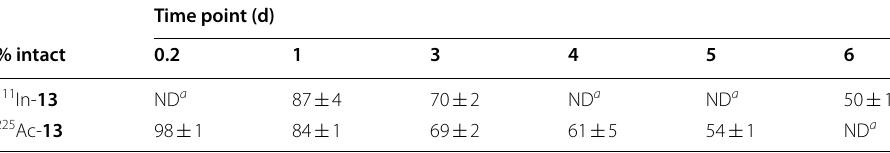
a ND not determined =